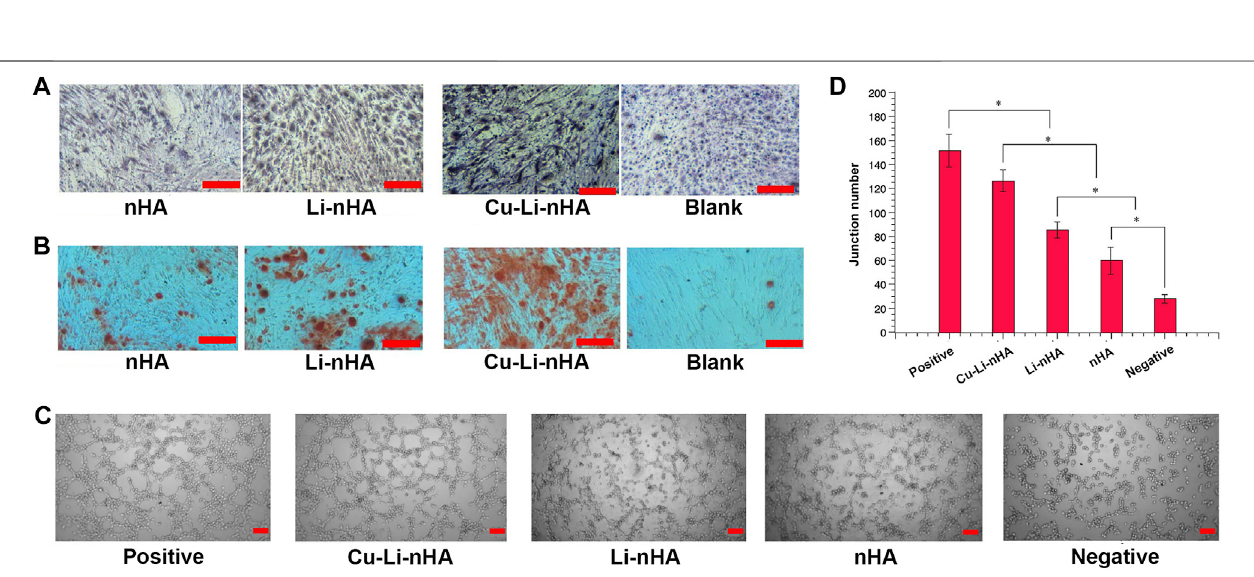
FIGURE 3 | (A) Immuno fl uorescence assays of BMSCs migration using Transwell device. BMSCs were labeled by CFSE (green) and DAPI (blue). Scale bar in the bottom right-hand corner of each image (red): 100 μ m. (B) The number of migrated cells under the membrane among different groups. Negative Group: complete medium; SDF-1 Group: SDF-1 + complete medium. Statistical analysis was conducted using a one-way analysis of variance with post-hoc Bonferroni ’ s multiple comparisons test. NS: p > 0.05, * p < 0.05.